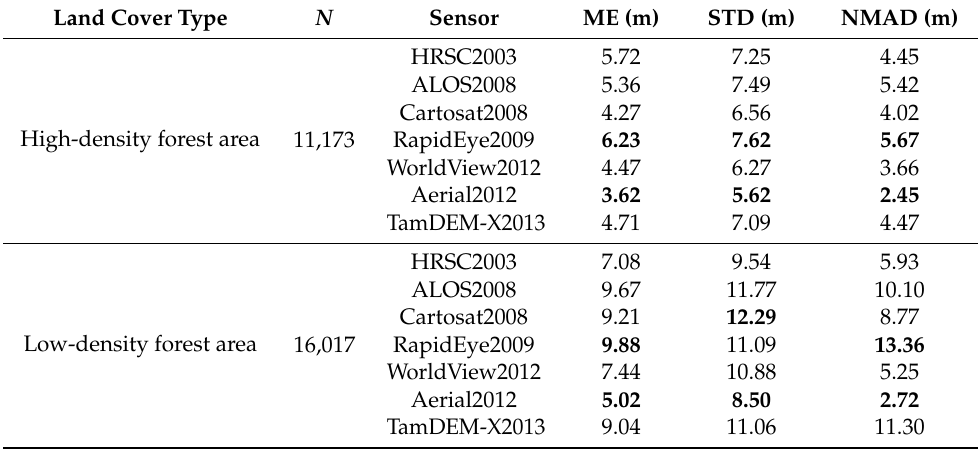
Table 6. Quality assessment for low-density and high-density forest based on the quality measures in Table 5 by using LiDAR data from 2001 as reference for HRSC2003 and from 2010 as references for the other DSMs (the highest and lowest values are marked in